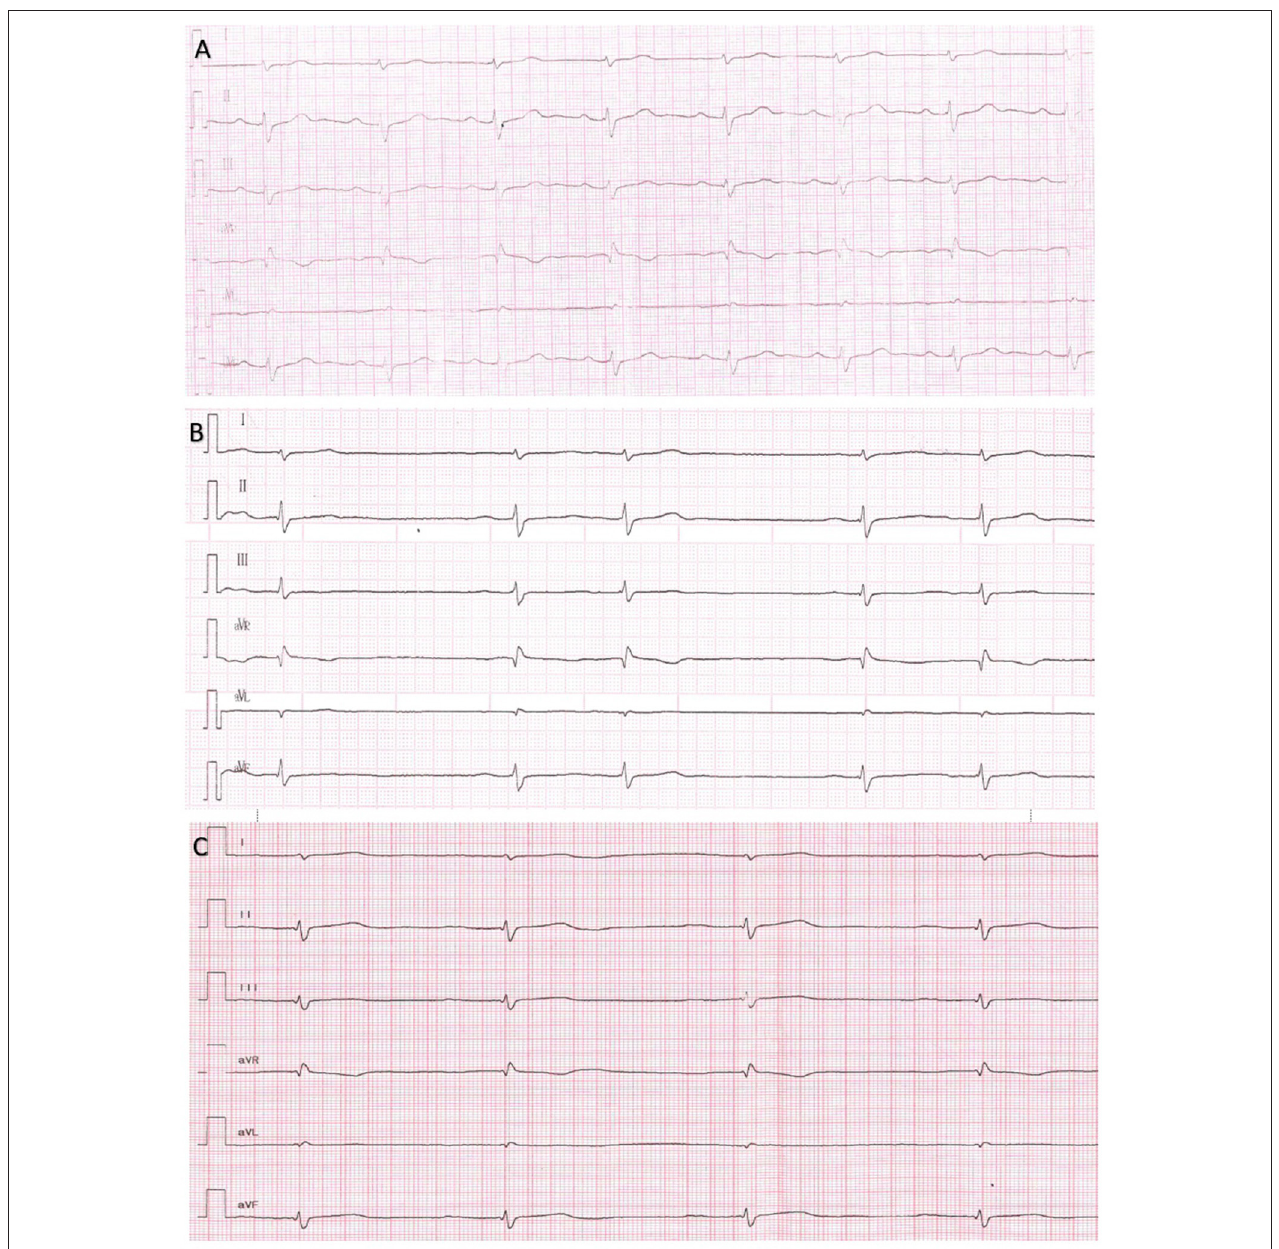
FIGURE 3 | Series of Electrocardiograms from a patient 5 showing reduced amplitude of P wave and AV conduction in dynamics. (A) 13 y.o. P wave amplitude 2.4mm, P wave duration 70ms, PQ 160ms. (B) 14 y.o. P wave amplitude 1.5mm, P wave duration 100ms, PQ 200ms. (C) 15 y.o. P wave amplitude 1mm, P wave duration 110ms, PQ